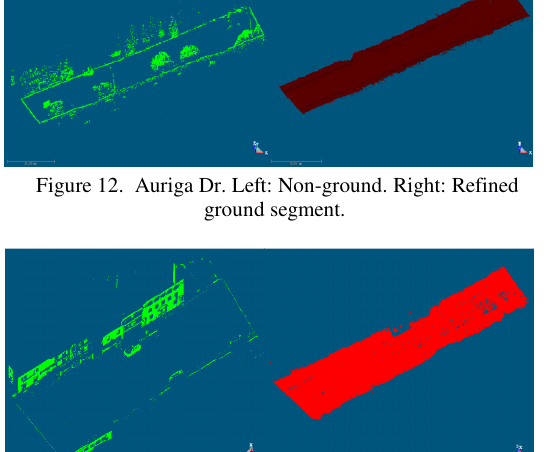
Figure 9. Dalhousie St. Left: Non-ground segment. Right: Ground segment.